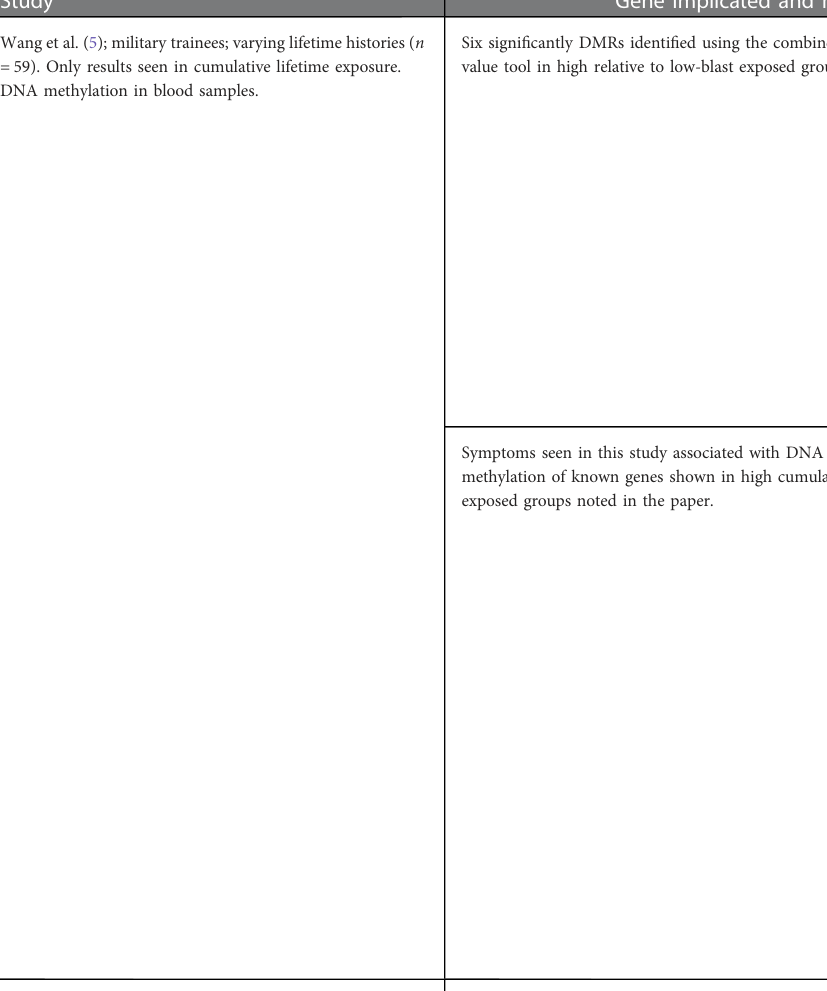
US marines ( n =98). Blood